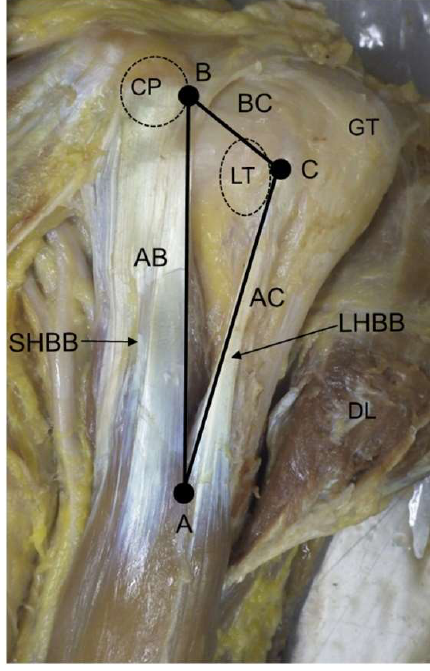
Figure 1. Anterior view of the left shoulder joint. A : Confluence between the LHBB and SHBB. B : Lateral side of the SHBB at the top of the CP level. C : Medial side of the LHBB tendon at the top of the lesser tubercle level. CP, coracoid process; DL, deltoid; GT, greater tubercle; LHBB, long head of biceps brachii; LT, lesser tubercle; SHBB, short head of biceps brachii.